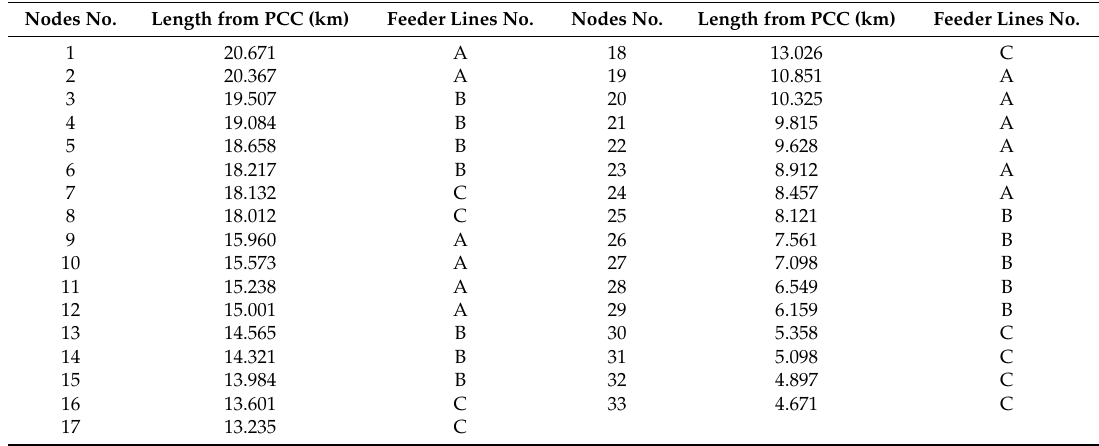
Table A1. Information of feeder lines in wind farm.